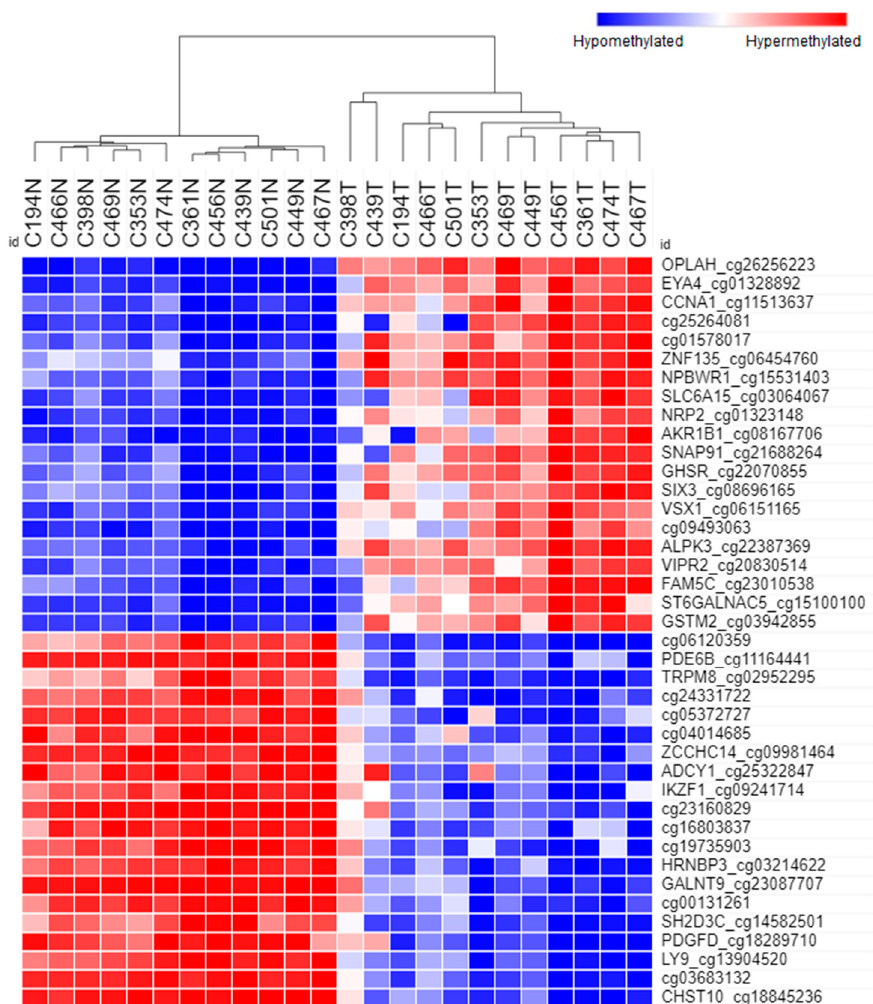
Figure 2. The hierarchical clustering and heatmap represent 40 significant methylation loci for open chromatin regions (20 hypermethylated and 20 hypomethylated). The dendrogram shows that all the samples are distinguished according to cancer (T) and normal (N) groups. The red boxes refer to the hypermethylated loci while the blue boxes denote the hypomethylated loci.